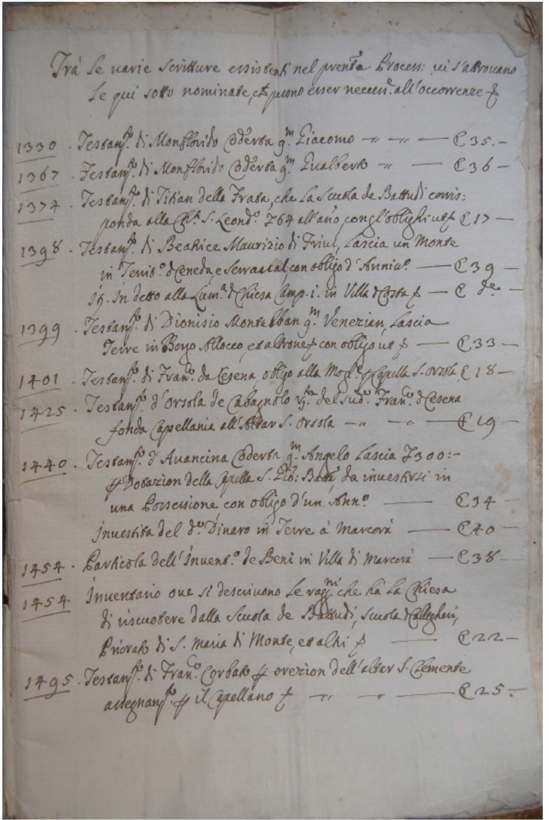
Figure 5. Donations (XIV–XV sec.) made to the Dome of Conegliano, from the Church’s